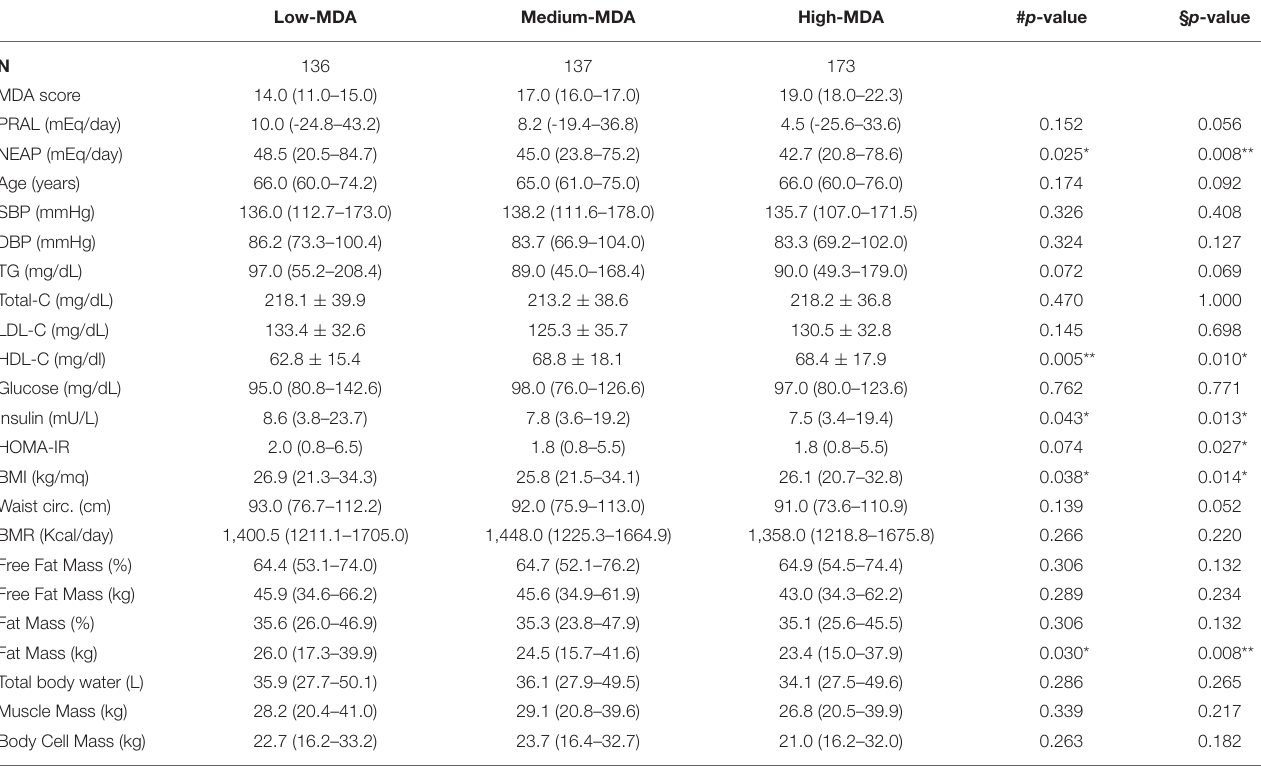
TABLE 3 | Population characteristics per MDA score